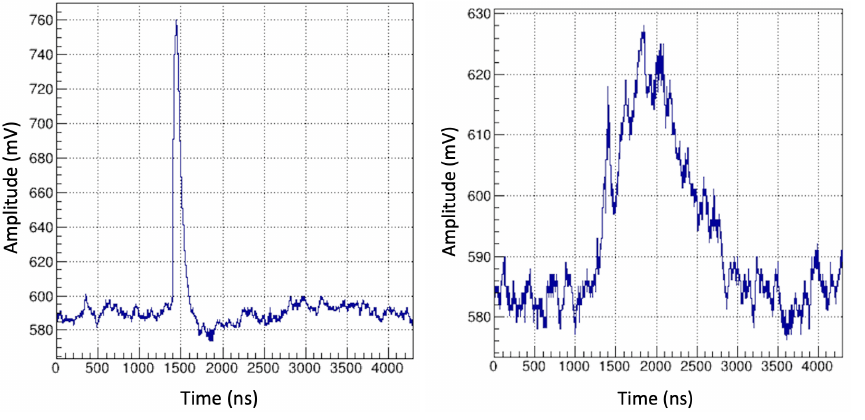
Figure 7. Example pulses with full width at half-maximum less ( left ) and larger ( right ) than 500 ns for the TPB-coated